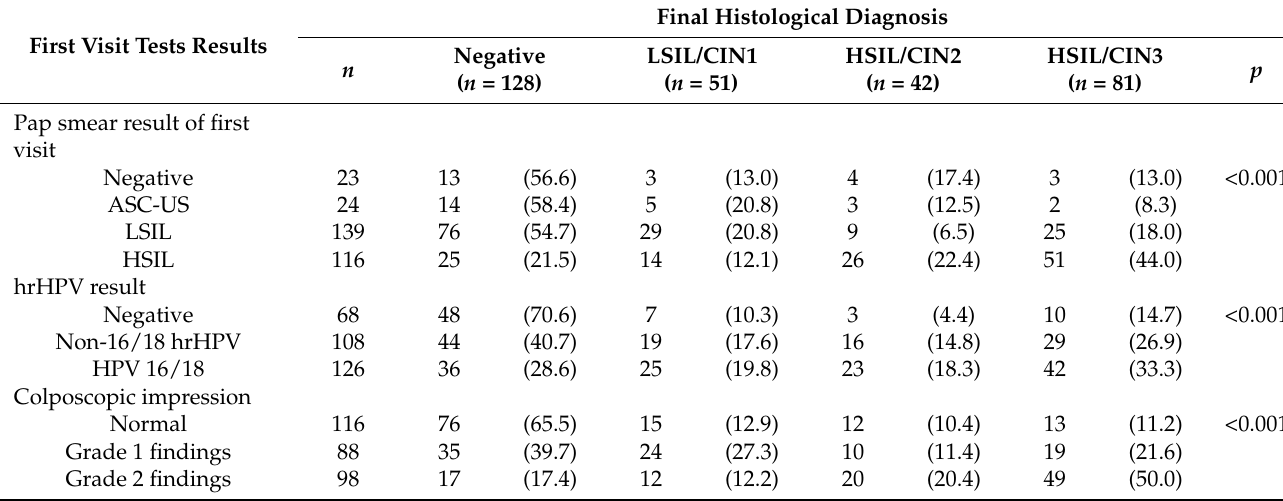
Table 3. Correlation between the Pap test result of first visit, hrHPV status and genotyping (negative vs. non-16/18 hrHPV vs. HPV 16/18), colposcopic impression, and the final diagnosis. Values are presented as absolute numbers and